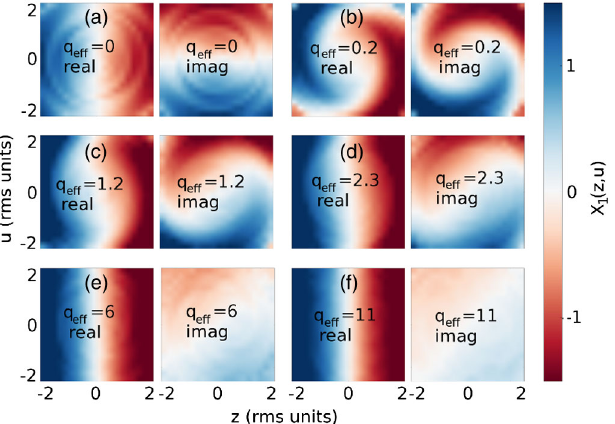
FIG. 2. 3D-G bunch. (a) – (f) The mode 1 longitudinal distri- bution, X 1 ð z; u Þ , for different values of the space charge param- eter q . Without space charge, X 1 ð z; u Þ ∝ e i θ . With increasing eff q , X 1 ð z; u Þ transforms gradually to the first space charge eff harmonic [see Fig. 1(a)]. At large q by a purely real function.